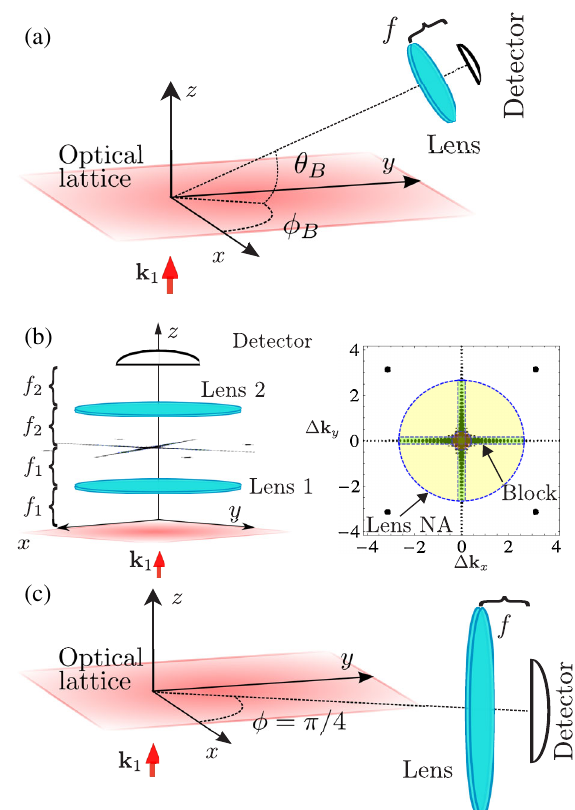
FIG. 16. Schematic illustration of the experimental configura- tions to detect AFM ordering of fermionic atoms in an optical lattice. The atoms are confined in the 2D optical lattice close to the z ¼ 0 plane, and the incident light propagates towards the positive z direction. In (a), the elastically scattered light corre- sponding to the emerging additional Bragg peak generated by the AFM ordering is collected by a small lens. In (b), the setup is closely related to that of Ref. [26]. The two lenses have focal lengths f 1 and f 2 . The light scattered in the near-forward direction is first collected by lens 1. In the focal plane, the scattered light is selectively stopped by a block in order to suppress the intensity of the elastically scattered light at the detector. The shape and the size of the block can be optimized for different measurements of collective excitations or of temper- ature. In (c), the scattered light is collected near the perpendicular scattering direction of θ ¼ π = 2 , to measure transverse spin